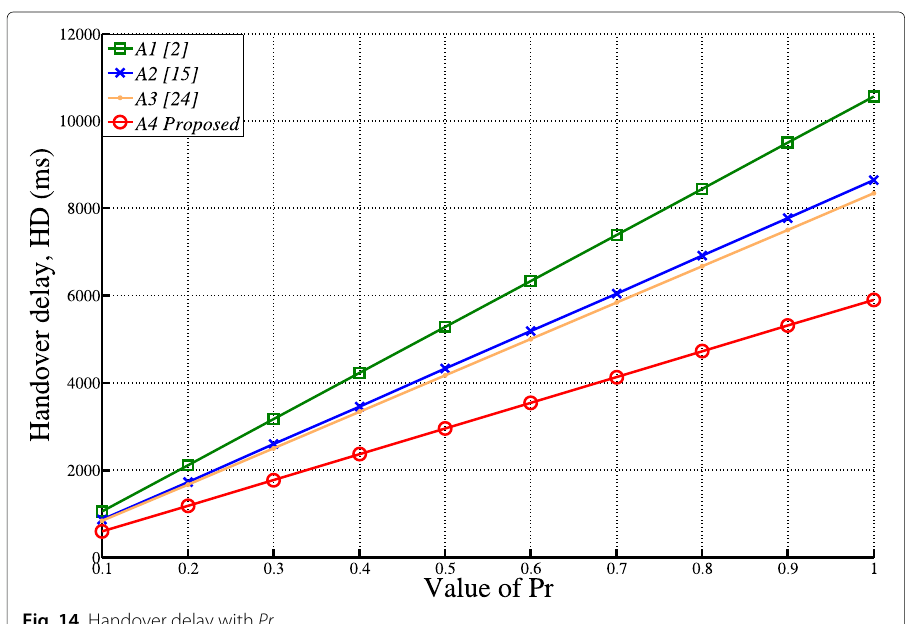
Fig. 14 Handover delay with